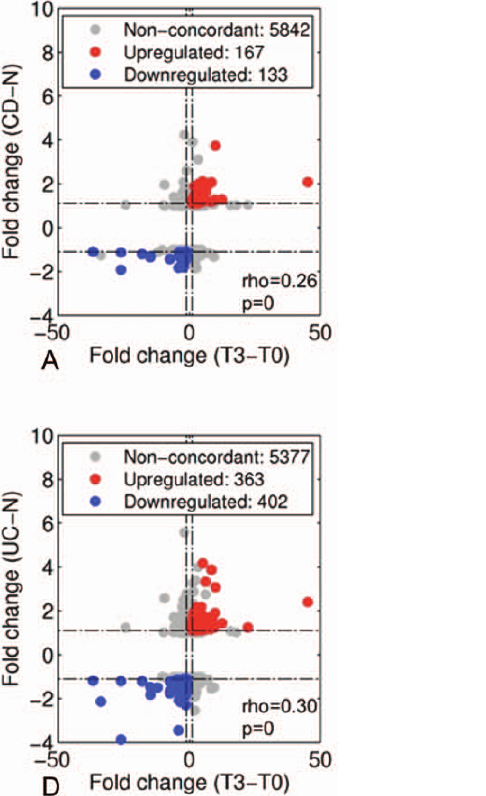
Figure 6. Concordance analysis between TNBS-colitis and IBD transcriptomes at the level of single gene loci. T3 vs. T0 , T7 vs. T0 and T12 vs. T0 compared to CD vs. normal (top) and UC vs. normal (bottom). (A–F) Scatterplots of FCs in rat data (x-axis) compared to FCs in the human data (y-axis). Rho values correspond to Spearman correlation coefficients with p-values representing the level of significance of the correlation. Concordant up- and down-regulated genes are represented as red and blue circles respectively. Non- concordant genes are shown as grey circles. Numbers in the legend correspond to the total number of genes assigned to each category. B, C, E and F are only shown in the supplemental section (Figure S1).